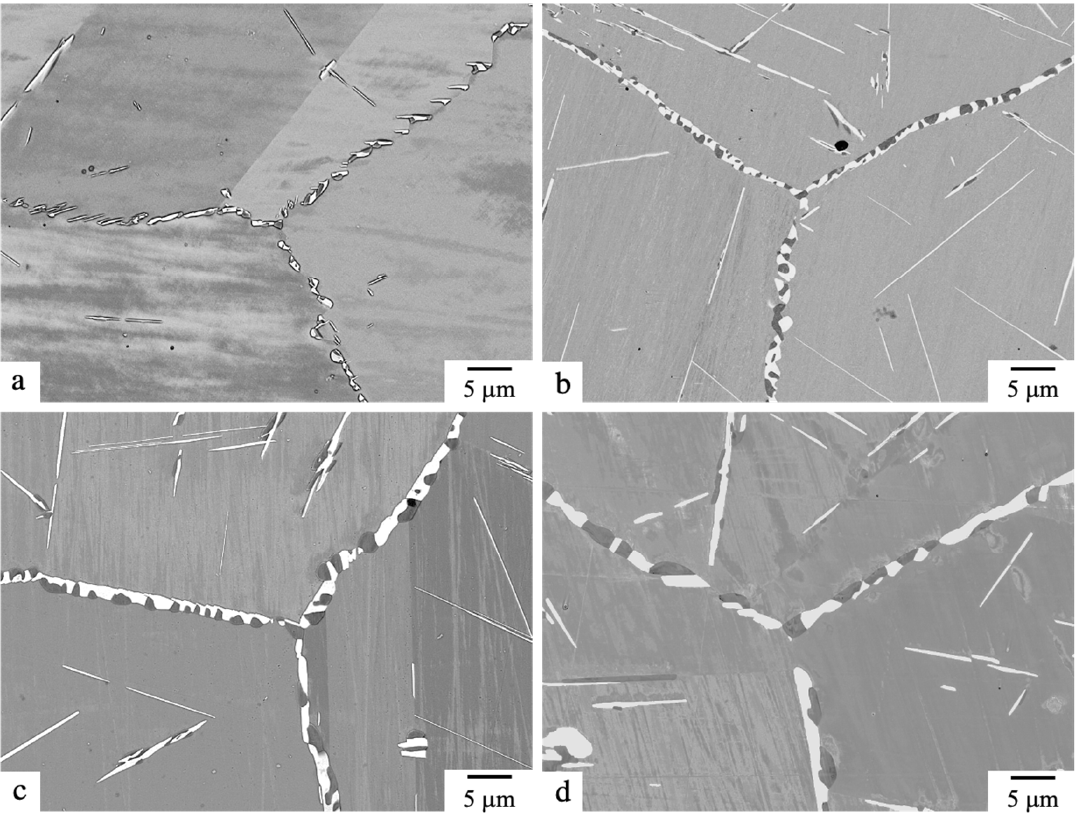
Figure 6. Backscattered electron images of Ni-3.3Nb-39.4Cr solution treated and then aged at 1273 K for ( a ) 1 h, ( b ) 12 h, ( c ) 100 h and ( d ) 1000